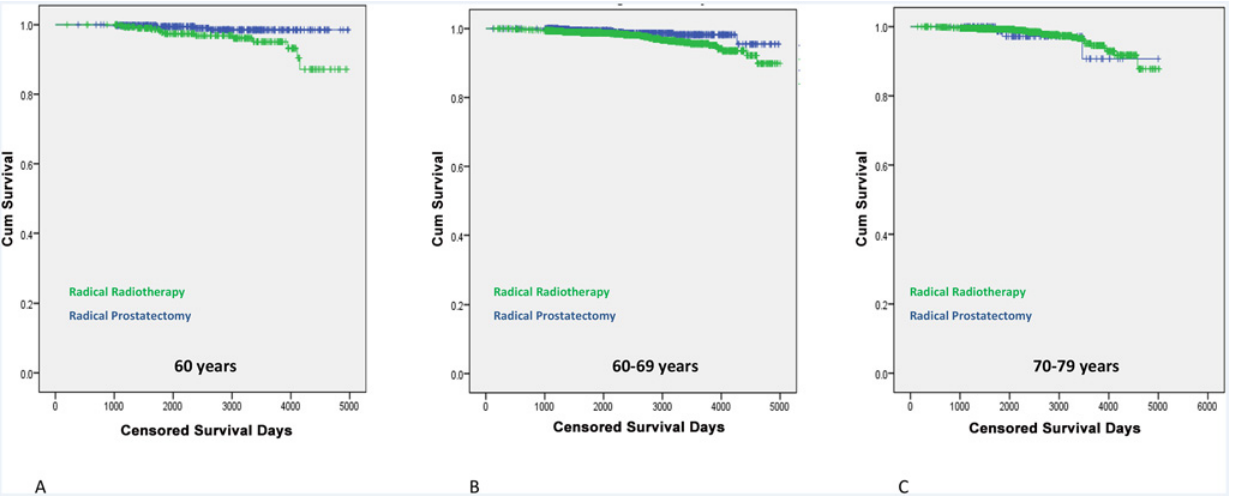
Fig 4. Cumulative cancer specific survival from radical prostatectomy and radical radiotherapy in age stratified groups.